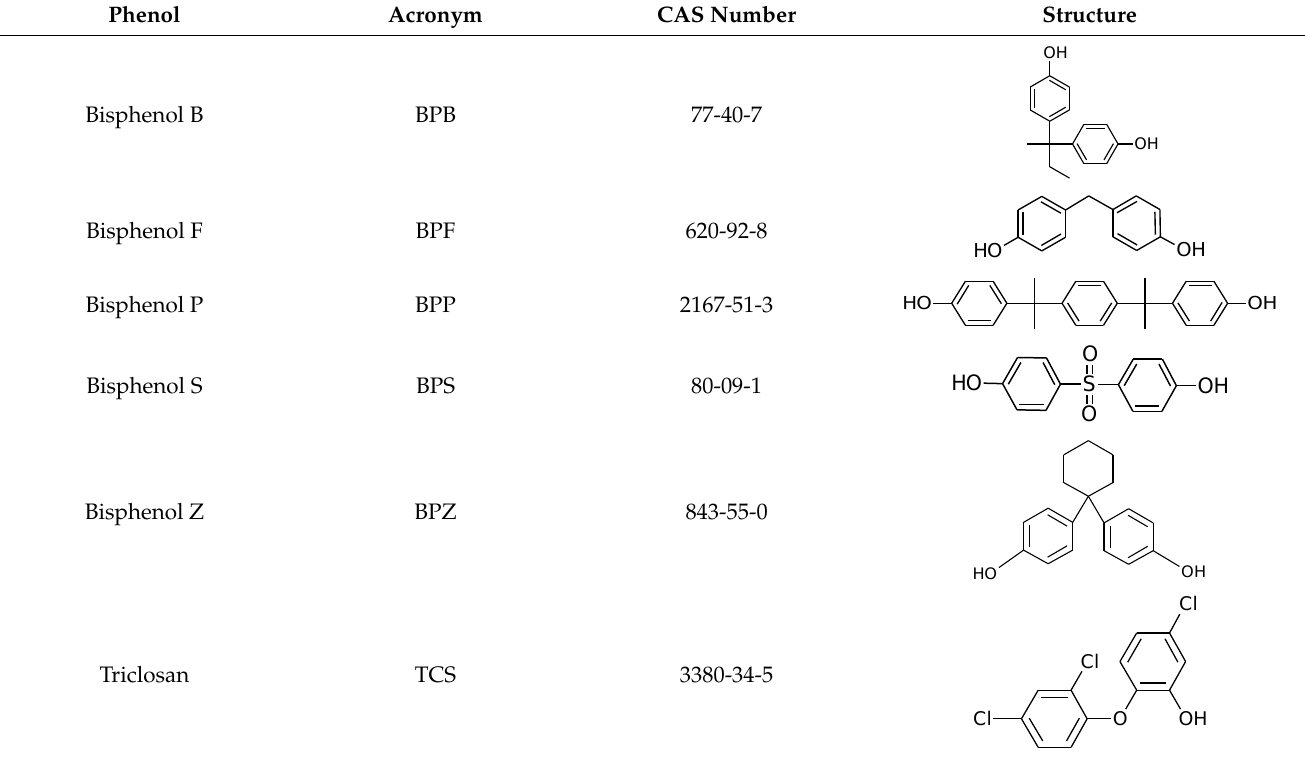
Table 1. Chemical structures of the six target phenols.